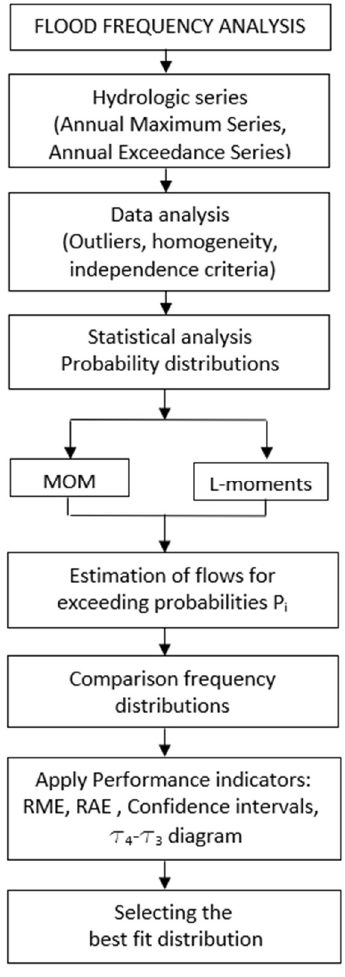
Figure 1. Methodological approach.